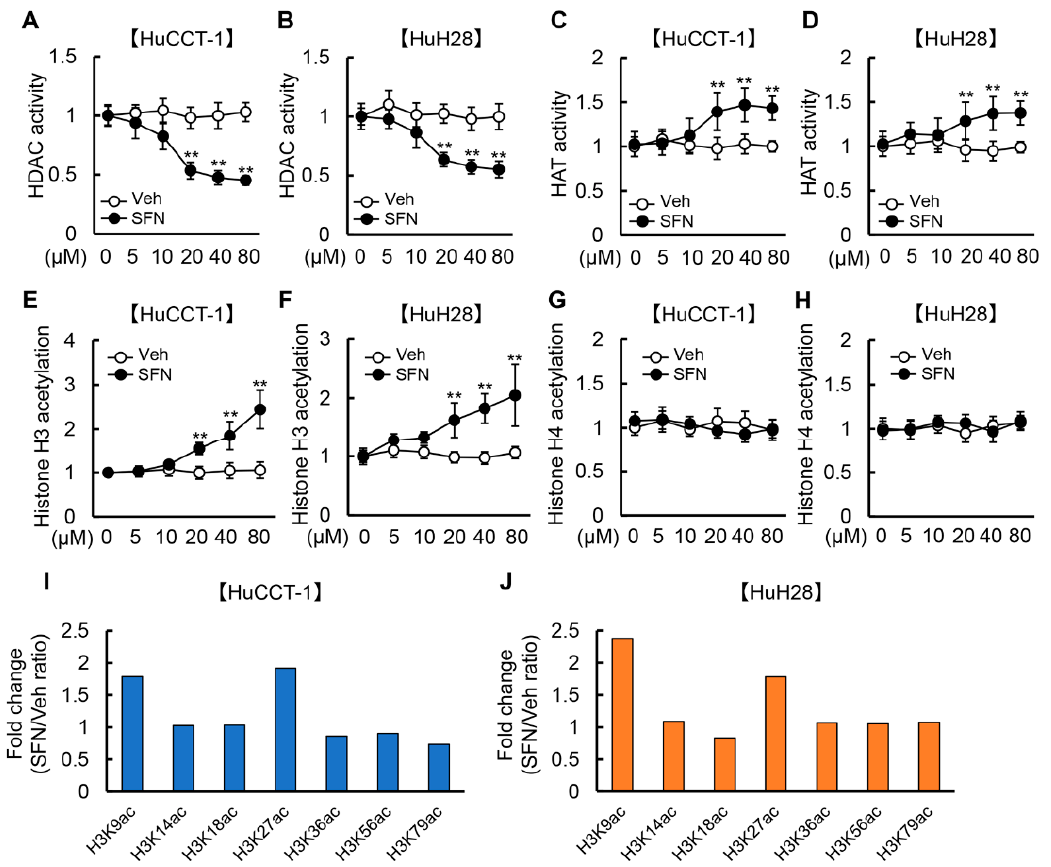
Figure 1. HDAC activity and histone H3 acetylation by treatment with SFN in iCCA cells. ( A – H ) HDAC activity ( A , B ), HAT activity ( C , D ), total histone H3 acetylation ( E , F ), and total histone H4 acetylation ( G , H ) in HuCCT-1 and HuH28 cells treated with SFN (0–80 μ M). The values are shown as fold changes relative to 0 μ M for each treatment group. Data are mean ± SD ( n = 3 independent experiments with n = 8 samples per condition). ** p < 0.01 compared with the group treated with vehicle (Veh) at the same concentration. ( I , J ) Graphical analysis of the binding intensity of H3K9ac, H3K14ac, H3K18ac, H3K27ac, H3K36ac, H3K56ac, and H3K79ac in HuCCT-1 ( I ) and HuH28 ( J ) cells treated with SFN (20 μ M) by using Histone H3 Peptide Array ELISA Kit. The values are shown as fold changes relative to Veh treatment at the same concentration.